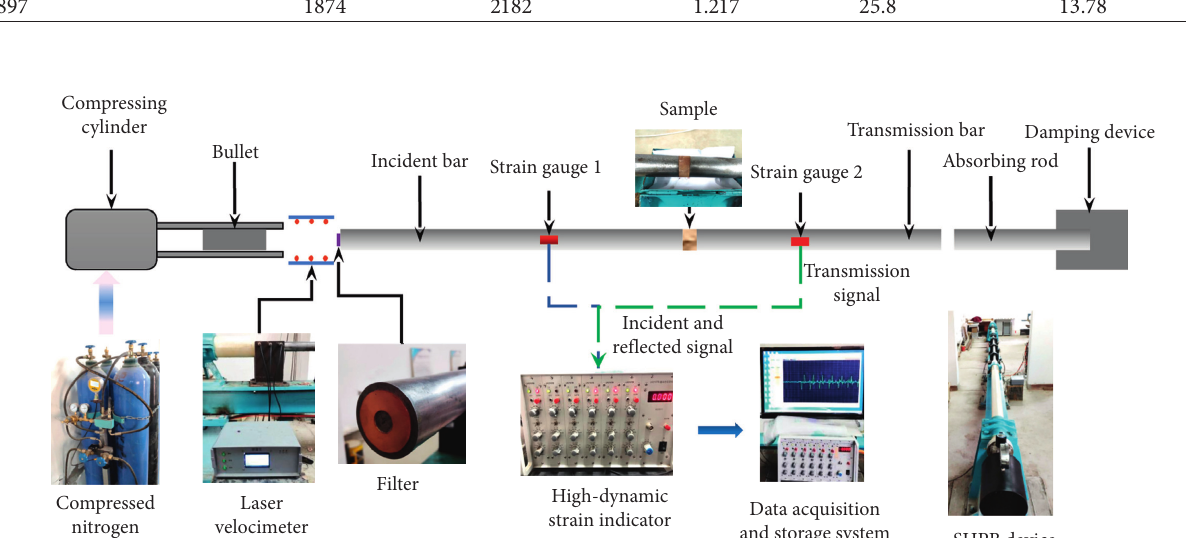
Figure 2: Structure composition of SHPB system.